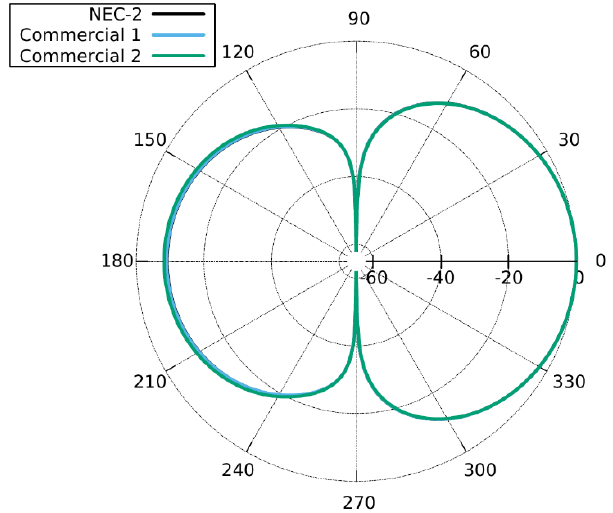
Fig. 8. Normalised radiation pattern of the analysed three-element Yagi in the E-plane. Black line: nec2c; Blue line: commercial code 1; Green line: commercial code